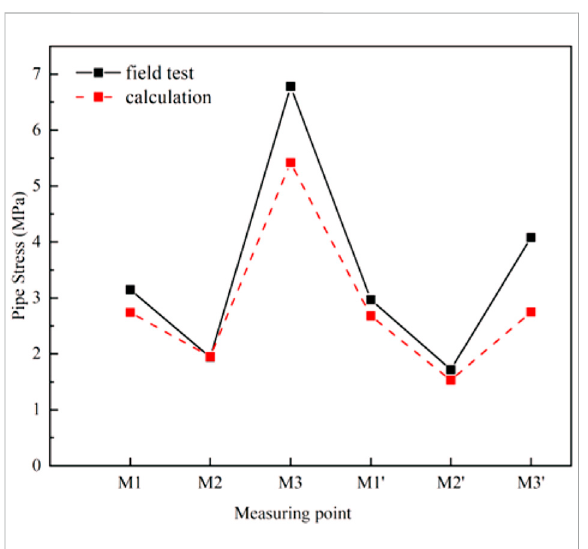
FIGURE 11 Pipeline stress at each point under the central